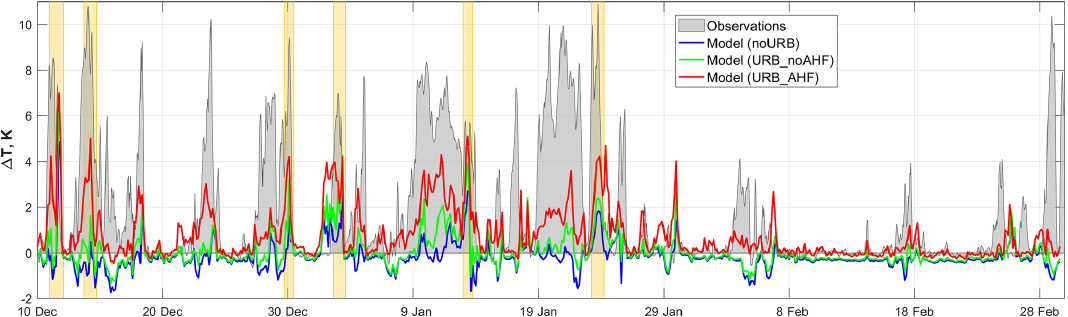
Figure 7. Intercomparison of the observed (gray shading) and modeled (the red, green and blue lines for URB_AHF, URB_noAHF and noURB runs, respectively) UHI intensity. The UHI intensity is taken as (cid:49)T U1 for the observations and the corresponding (cid:49)T values for the R1 grid cells collocated with the U1 and R1 sites in the model. The model output was sampled at 3h intervals. The orange shading identifies the cold periods with a strong UHI which were selected for sensitivity studies. These periods differ from cases 1–6 that were used